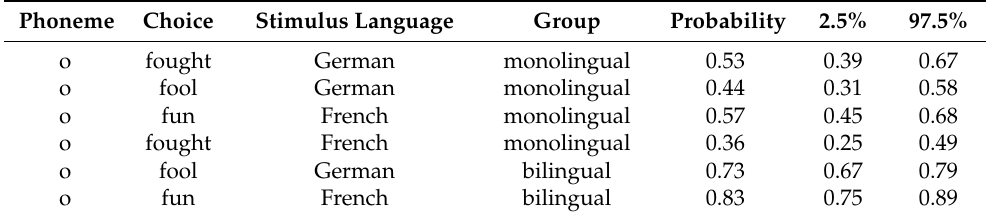
Table 4. Most probable responses given /o/ in French and German by L1 English monolinguals and L1 English bilinguals.